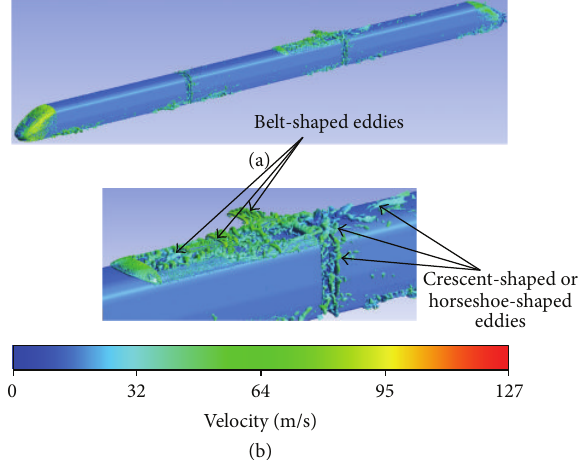
Figure 9: Isosurface of the instantaneous normalized Q-criterion ((a): entire vehicle; (b): magnified view).